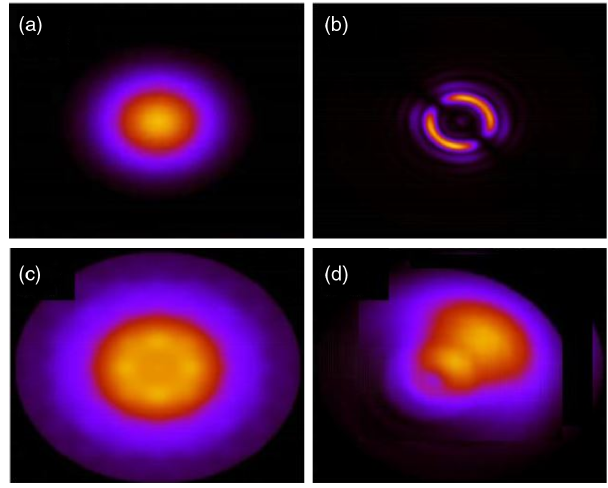
FIG. 10. Transverse optical field profile at the out-coupled mirror: (a) for the Gaussian electron beam with zero tilt, (b) for the Gaussian electron beam with a tilt of 0.42 mrad, (c) for a hollow electron beam with zero tilt and (d) for a hollow electron beam with the tilt of 0.42 mrad, all at g ¼ − 0 . 6 and λ ¼ 10 μ